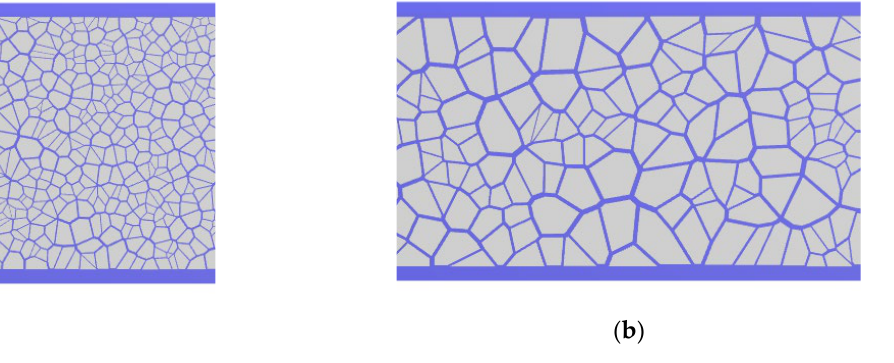
Figure 3. Fracture criterion with tensile and shear failure.